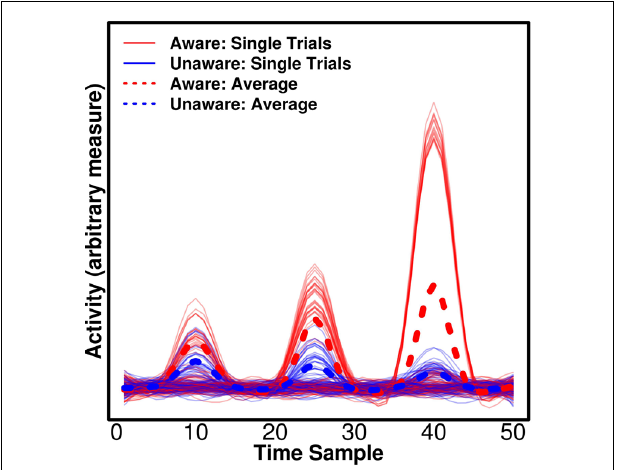
FIGURE 2 | Consistency of the neural correlates of consciousness (NCC). Three simulated, hypothetical signals of differing consistency and strength are plotted. All could be candidate NCC, thus reflecting differences between trials classified as “aware” and “unaware” by a participant. For the first component, there is a small average difference, but the component is not consistently larger for “aware” trials, making it unlikely that the component reflects awareness.The component could reflect a prerequisite for consciousness (NCC-pr) as it has to be present for awareness, but it does not guarantee awareness. For the second component, there is a medium average difference, and the component is consistently larger for “aware” trials. On the single trial level, the component thus reflects awareness and it may thus be an actual NCC. Finally, for the third component, there is a large average difference, but the component is only found on a subset of “aware” trials, and it does thus not consistently reflect awareness.The component could thus reflect processes that are consequences of awareness (NCC-co), which occur exclusively for “aware” trials, but may not occur on every single aware trial. Note that traditional univariate statistics based averaged participant-specific averages would erroneously find more evidence for the last component being the NCC proper in this